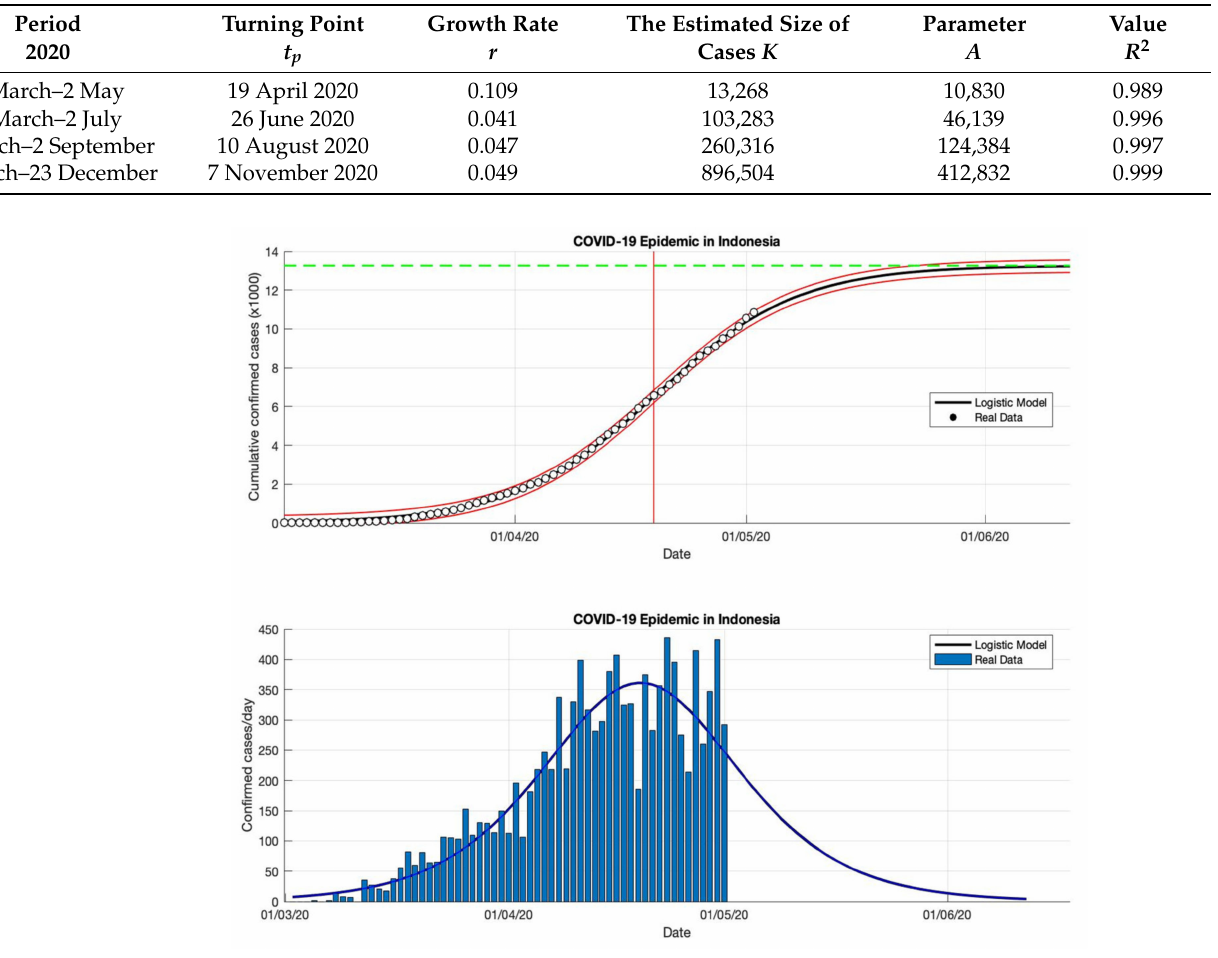
Figure 16. In the above figure, the prediction results of the logistic growth model for cumulative infected cases are compared with the actual data, while the two red lines between the black lines represent a prediction error limit of about 5%. The dashed green line predicts the total size of infected cases in the final phase of the epidemic. The red line intersects the cumulative case curve to predict the turning point or peak point of the epidemic (this line is parallel to the top of the curve from the below figure). In the below figure, the prediction results of this model for daily infected cases